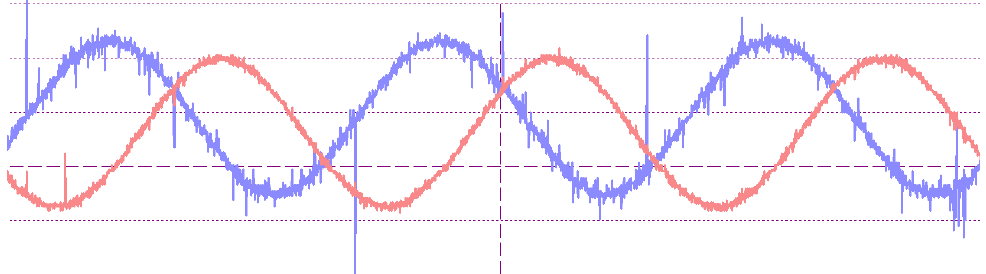
Figure 12. Sensor Current